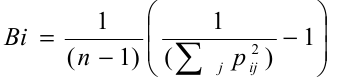
Table 1. Mean ± standard deviation of hydrological